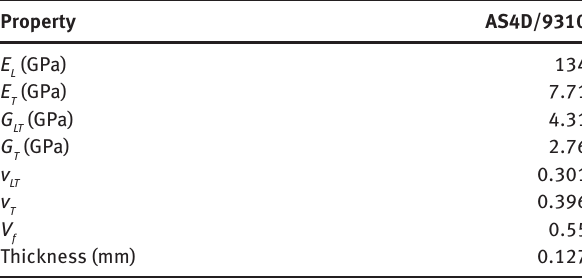
Table 1: Material properties of the carbon/epoxy composite